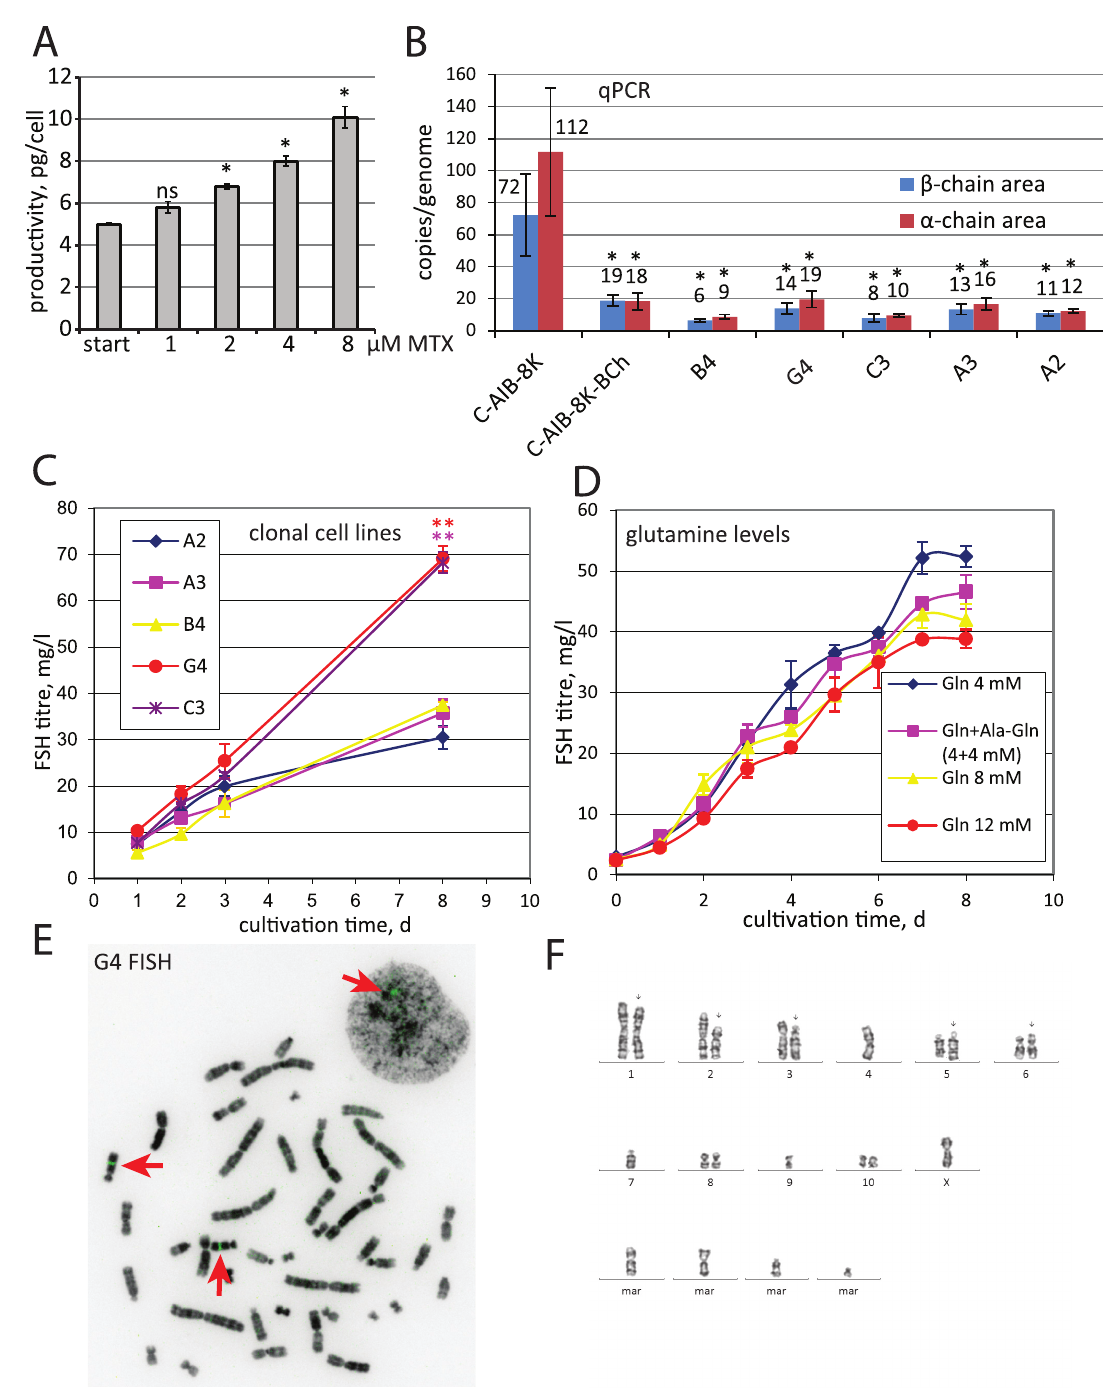
Fig 2. Productivity and transgene copy number for oligoclonal cell populations during the MTX amplification and for selected clonal cell lines. A—–Secretion level of FSH for cell populations upon MTX amplification by ELISA, n = 2. B—qPCR analysis of the expression cassette copy numbers per haploid genome for the oligoclonal population after the amplification, second transfection and subsequent cell cloning. B-chain area—primer pair SQ-FB-F—SQ-FB-R. Error bars represent standard deviation, n = 3. C—FSH accumulation curves by ELISA for selected clonal cell lines during batch cultivations, n = 2, t-test analysis of G4 and C3 samples versus A2 sample, only statistically significant differences are marked by asterisks. D—Effects of glutamine concentration on the FSH secretion level for the G4 cell line. E—FISH analysis of the G4 cells by the FITC-labeled probes toward the α -chain area (green channel). Arrows depict positions of fluorescent bands at condensed chromosomes and the interphase nuclei. F—Karyotype of G4 cells. Arrow indicates the probe location (at long-arm, chromosome